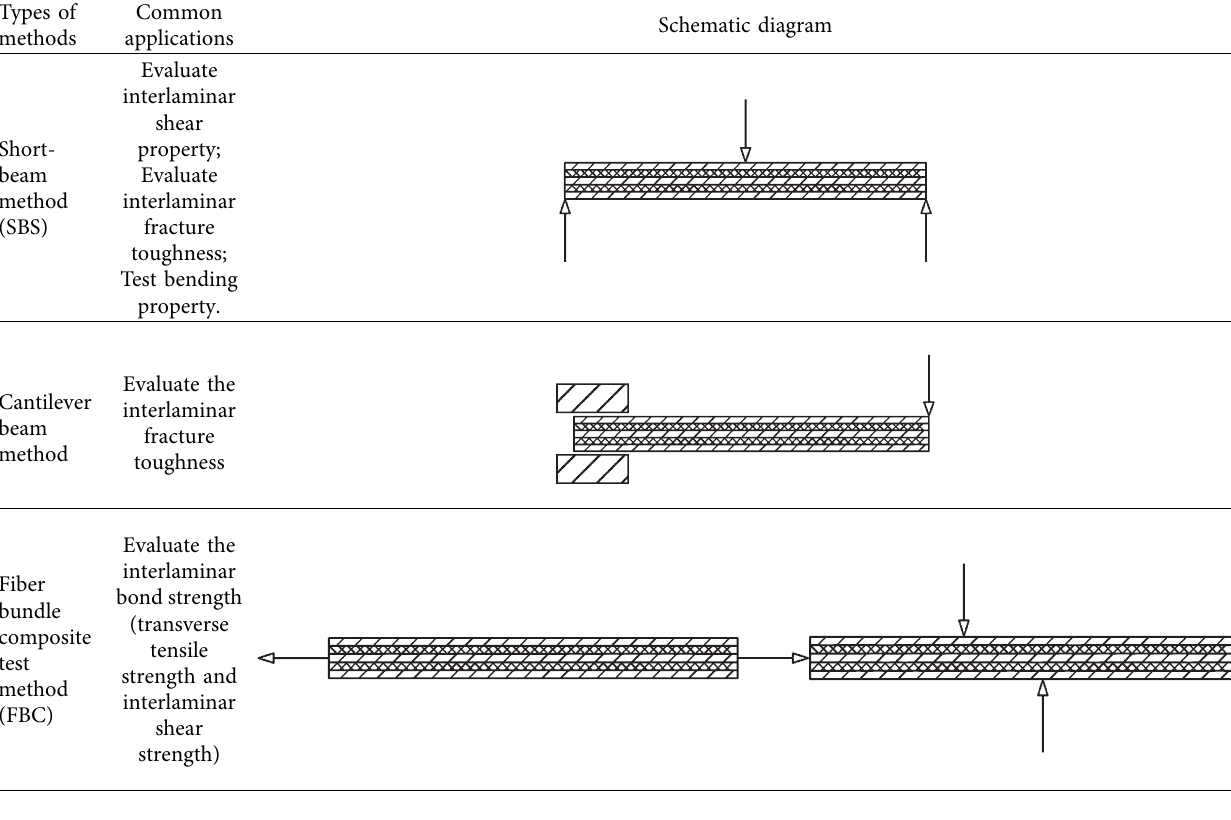
Table 1: Method for evaluating interlaminar property of FMLs.